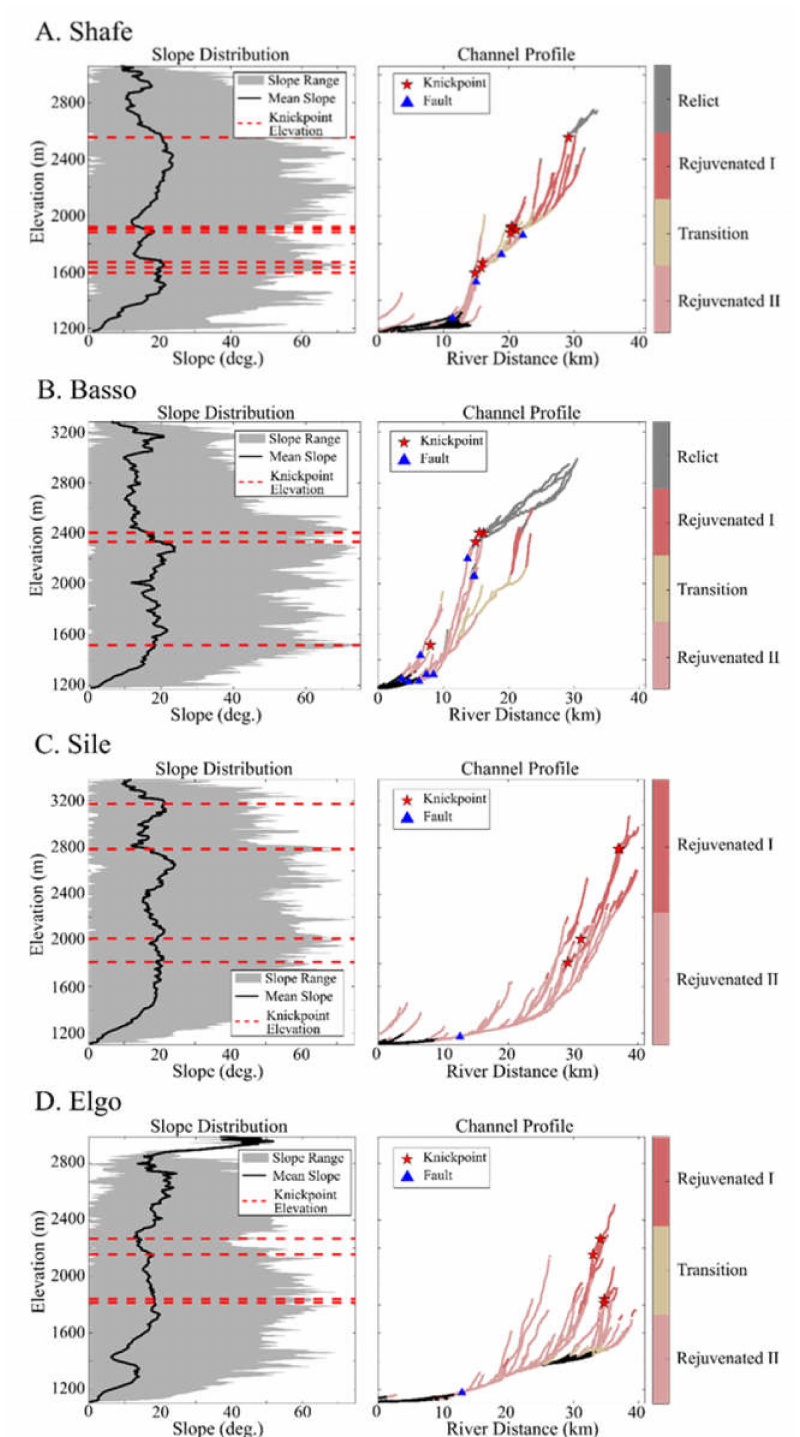
Figure 5. Relationship between slope angle (left) distributions with knickpoints, mapped fault intersections, and landscape rejuvenation alongside river profiles (right) for the ( A ) Shafe, ( B ) Basso, ( C ) Sile, and ( D ) Elgo catchments. Gray shading and black lines (left plots) are the range and mean catchment slopes at each elevation, respectively; red-dashed lines are the elevations of knickpoints. Lines (right plots) are river profiles as a function of upstream distance, colored by landscape